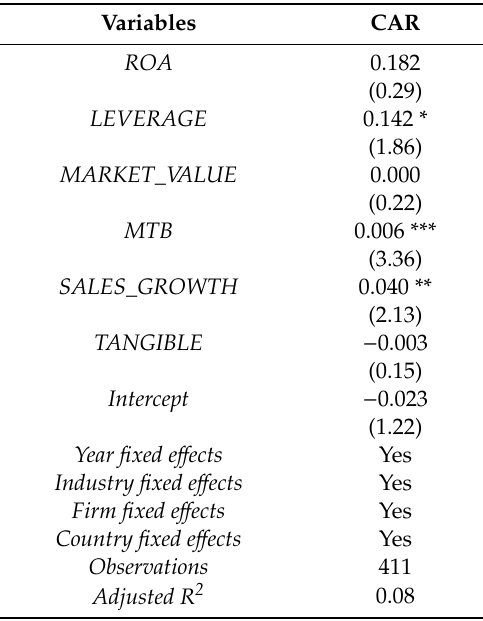
Table 5. Cross-sectional variation of